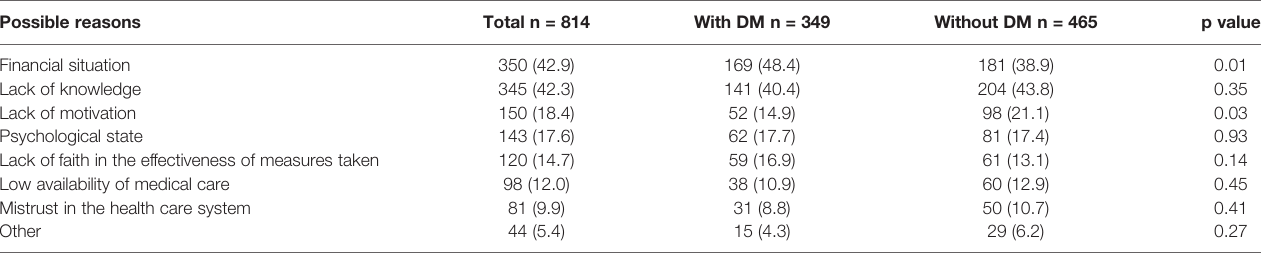
TABLE 4 | Barriers to daily adherence to healthy lifestyle in the general population: comparison between those with and without diabetes. Possible reasons